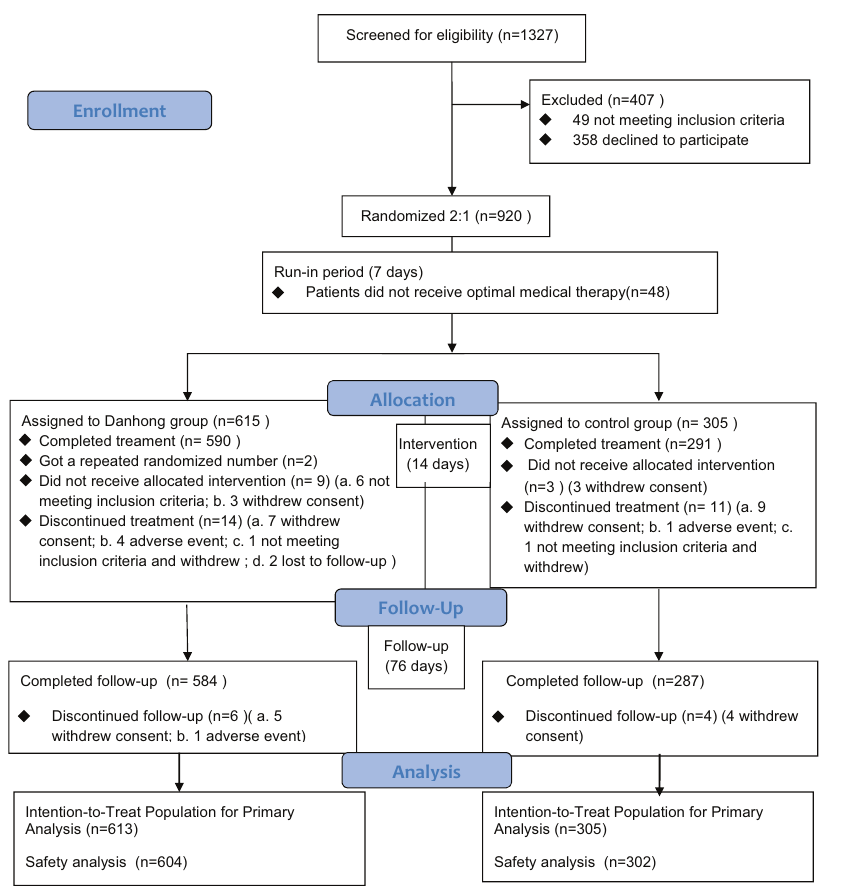
Fig. 1 The fl ow chart of the C-reactive protein (CRP), or platelet aggregation rate (PAR) at Day 14 ( P = 0.1222 – 0.9495) (Supplementary Table S10). Among the 906 patients who received the study drug, 60 patients reported 93 adverse events (AEs) in the DHI group, and 36 patients reported 58 AEs in the control group; the incidence of AEs did not differ signi fi cantly between the two groups ( P = 0.3597), and the same was true of the incidence of severe adverse events (SAEs) ( P = 0.9105). In addition, 4 patients reported new-onset major vascular events within 90 days (0.5%) in the DHI group and 1 (0.3%) in the control group ( P = 0.8502), and no severe or